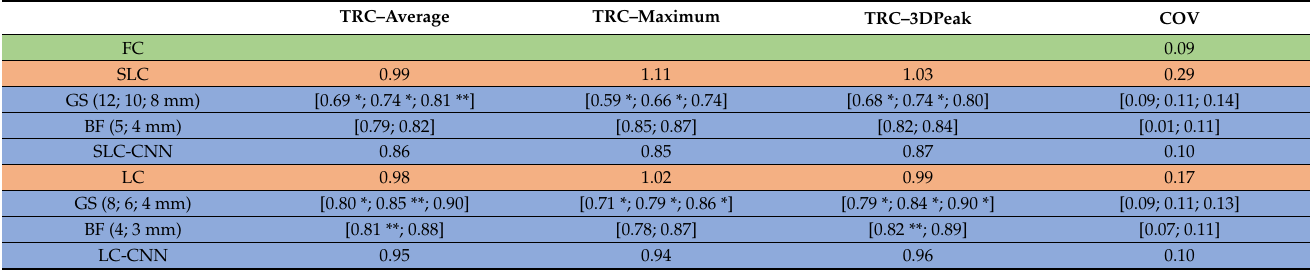
Figure A2. Illustration of a ( A ) FC, ( B ) SLC, ( C ) SLC-CNN, ( D ) BF 4 mm, ( E ) BF 5 mm, ( F ) GS 10 mm denoised 18 F-FDG PET scan (coronal orientation) from the Ingenuity TF PET/CT scanner. Illustration of a ( G ) LC, ( H ) LC-CNN, ( I ) BF 3 mm, ( J ) BF 4 mm, ( K ) GS 6 mm denoised 18 F-FDG PET scan (coronal orientation) from the Ingenuity TF PET/CT scanner. Table A1. Overview of the performance of the GS, the BF and the proposed CNNs denoising methods using the external test 18 F-FDG PET scans from the Ingenuity TF PET/CT and Vereos Digital PET/CT scanners. For the FC (green), SLC and LC (with (blue) and without (orange) post-processing) PET scans, the TRC and COV values are shown in each column.